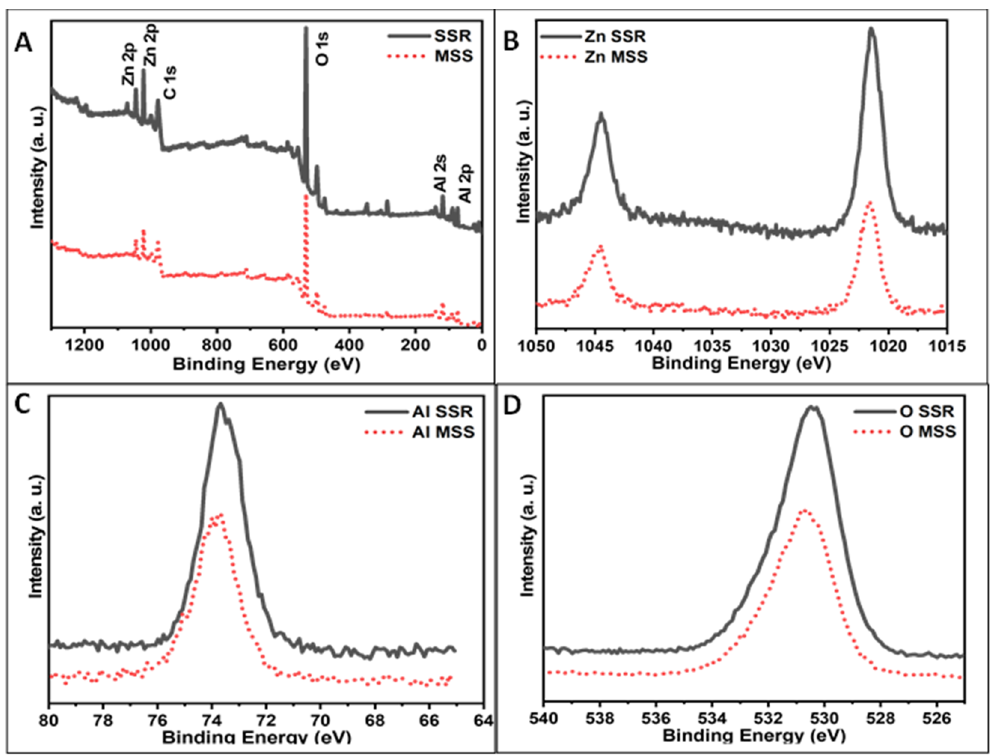
Fig. 4. XPS of zinc aluminate sample synthesized by both SSR and MSS, [A]: full survey, [B]: Zn 2p, [C]: Al 2p and [D]: O 1s.